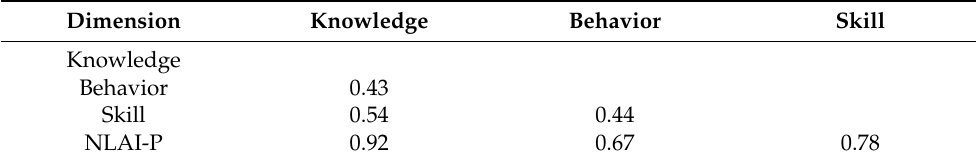
Table 5. Pearson correlation coefficients of